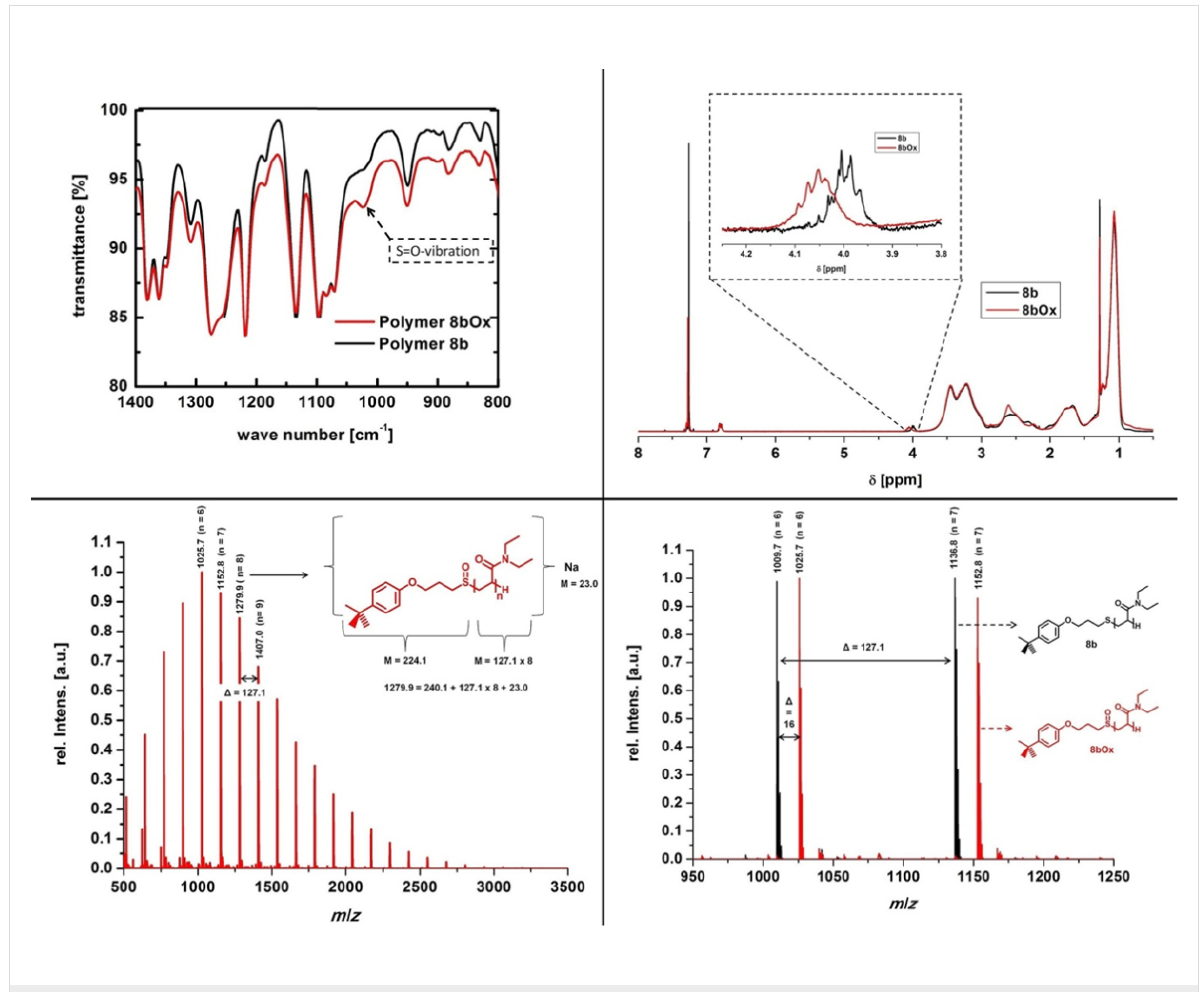
Figure 3: Top left: Section of the FTIR-spectrum of polymer 8b (black line) in comparison to 8bOx (red line); top right: 1 H NMR spectrum of polymer 8b (black line) and polymer 8bOx (red line) in CDCl 3 (300 MHz, rt); bottom left: Section of the MALDI–TOF spectrum of polymer 8bOx , supporting the high efficiency of the oxidation of the thioether linkage to the corresponding sulfoxides; bottom right: Comparison of the MALDI–TOF spectrum of polymer 8b (black line) with polymer 8bOx (red